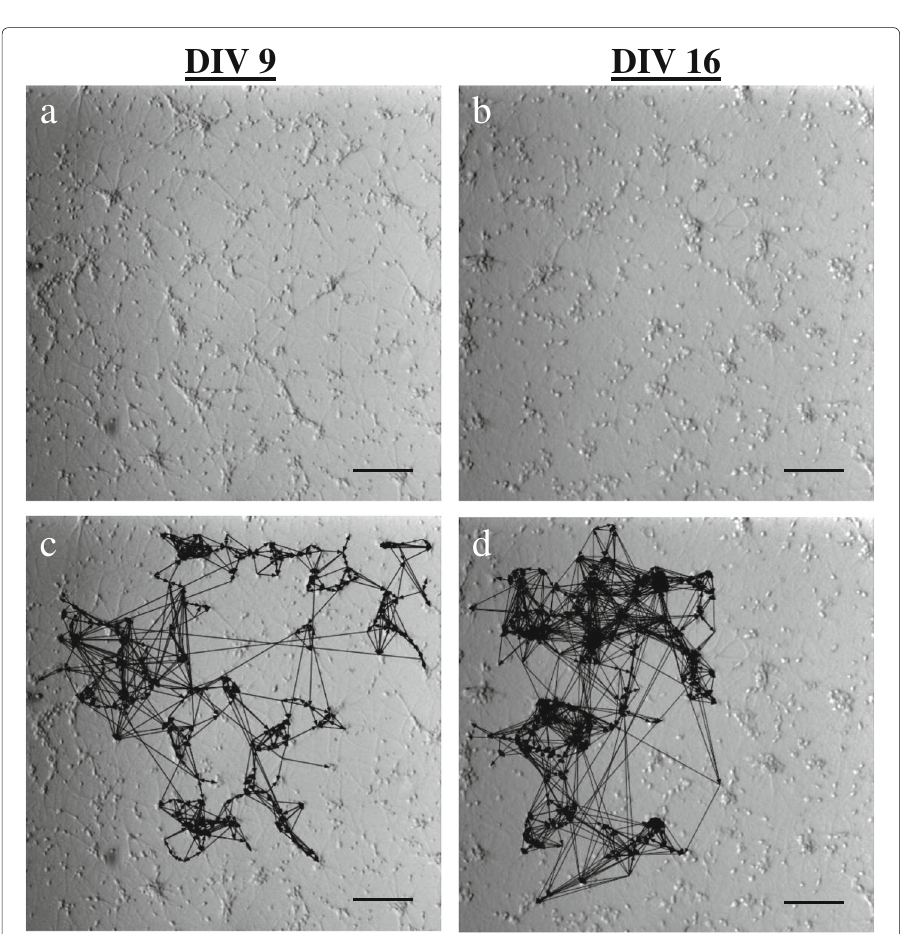
Fig. 4 Connectivity maps. For the same two networks shown in Fig. 2, bright-field image of a small (DIV 9) and b large (DIV 16) network bursting activity. Corresponding connectivity maps overlaid onto bright-field images: c 195 nodes and 874 links; d 186 nodes and and 1567 links. Scale bars: 200 μ